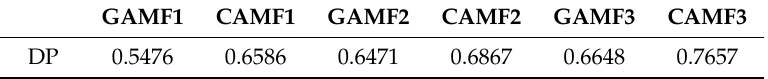
Table 6. Dataset-level precision (DP) using different affinity metric fusion methods.